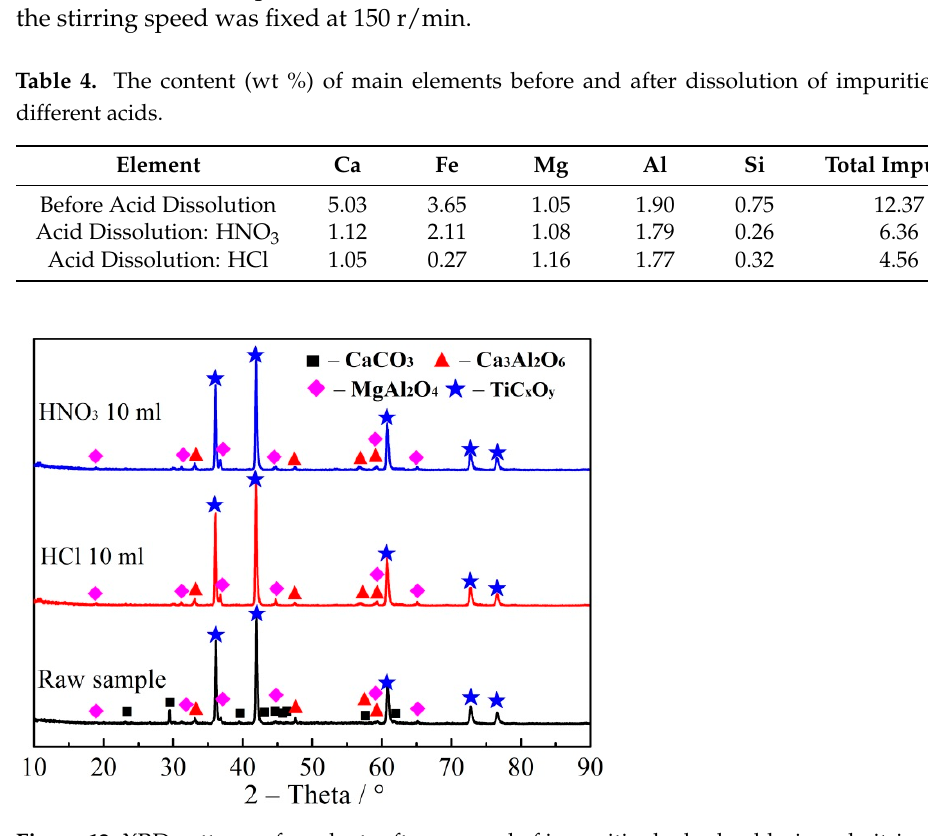
Table 4. The content (wt %) of main elements before and after dissolution of impurities with dif- ferent acids.